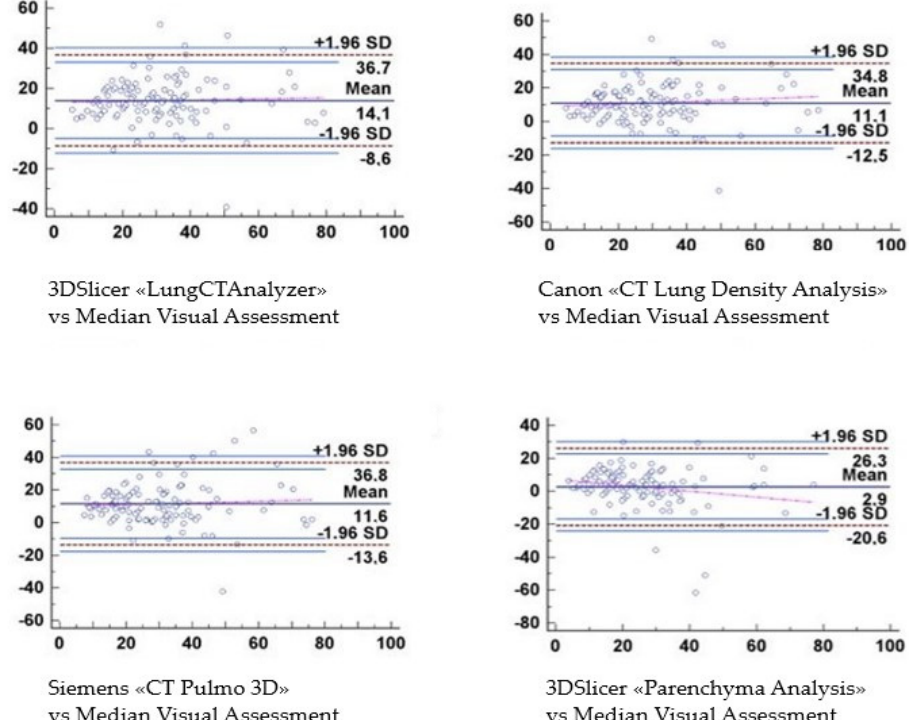
Figure 11. Bland–Altman graphics demonstrate the trend of the values assessed. For the software “LungCTAnalyzer”, the results lie in a range between 36.7 and − 8.6 with an SD of ±1.96. For the Canon software, the results filled the space between 34.8 and − 12.5 with an SD of ±1.96; for the Siemens software, instead, the values were positioned between 36.8 and − 13.6 with the same SD of ±1.96. Finally, the “Parenchyma Analysis” outcomes were placed between 26.3 and − 20.6 with an SD of ±1.96. SD = Standard Deviation.